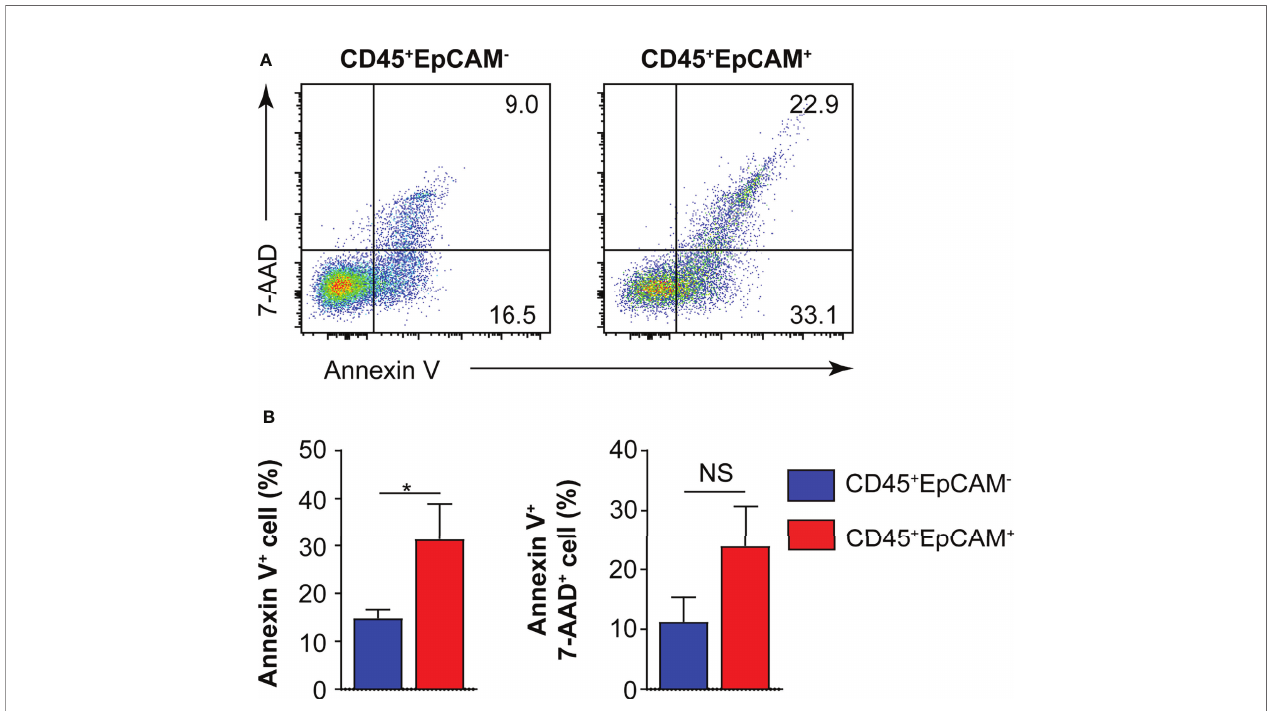
FIGURE 3 | CD45 + EpCAM + cells undergo apoptosis in the tumor microenvironment. (A) CD45 + EpCAM + and CD45 + EpCAM − cells from tumors of patients with lung cancer were stained with Annexin V/7-AAD kit to assess viability by fl ow cytometry. (B) The ratio of apoptosis in CD45 + EpCAM + and CD45 + EpCAM − cells is shown in (B) , respectively ( n = 6). Data are representative of six separate experiments. Error bars represent SEM. * P < 0.05 (Student ’ s t -test). NS, no signi fi